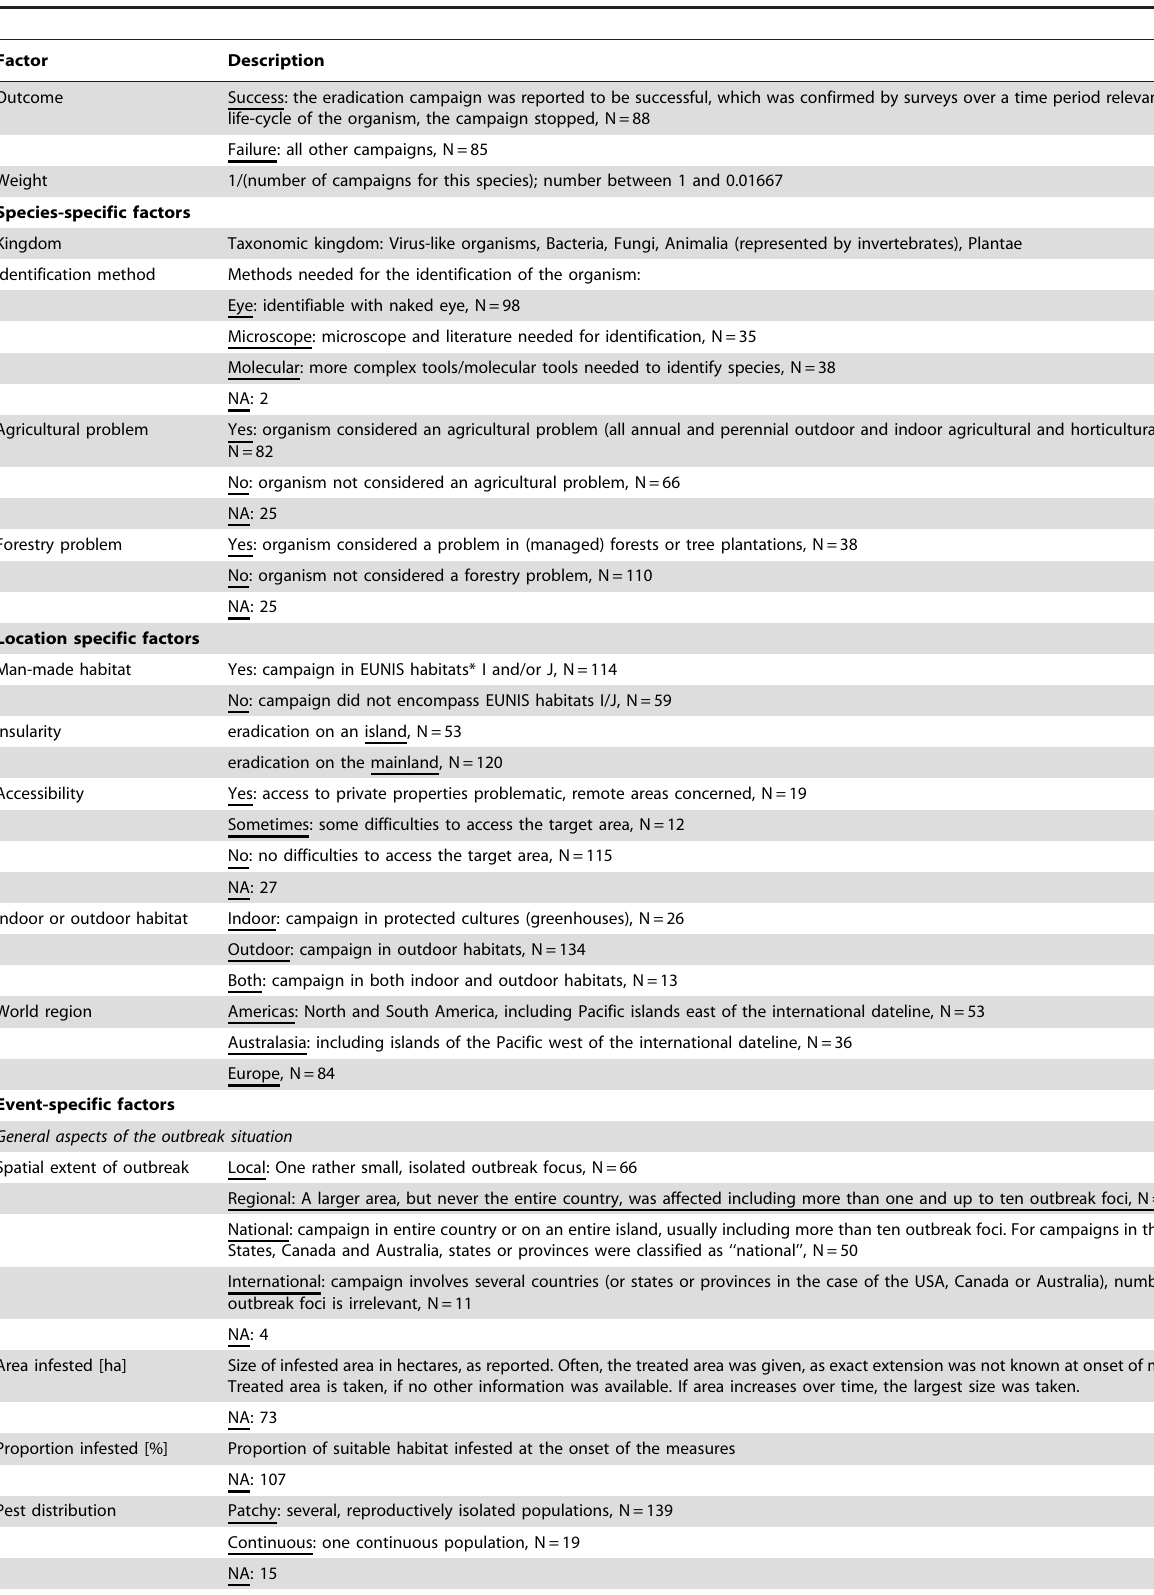
Table 1. Description of 29 potential success factors of 173 eradications against invertebrate plant pests, plant pathogens (viruses/ viroids, bacteria and fungi) and weeds, used in data mining